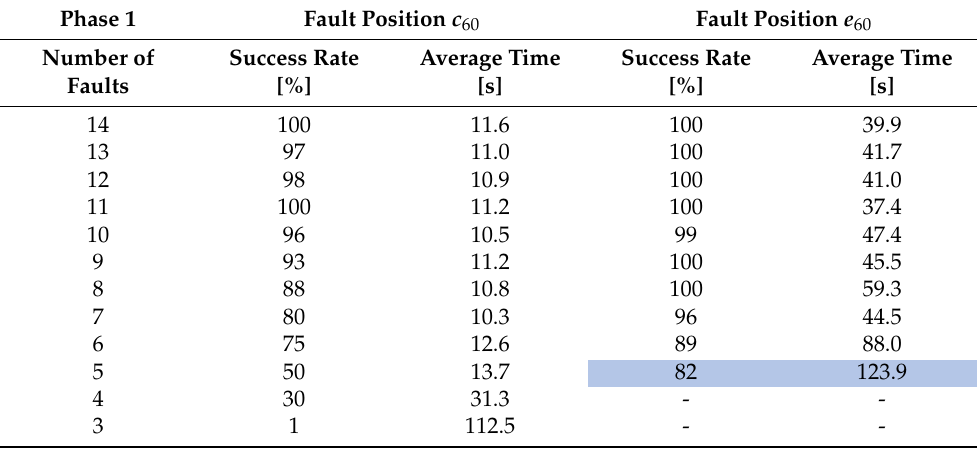
Table 2. Success rate and average time for each number of faults (Phase 1). “-” indicates that the result was not output within 72